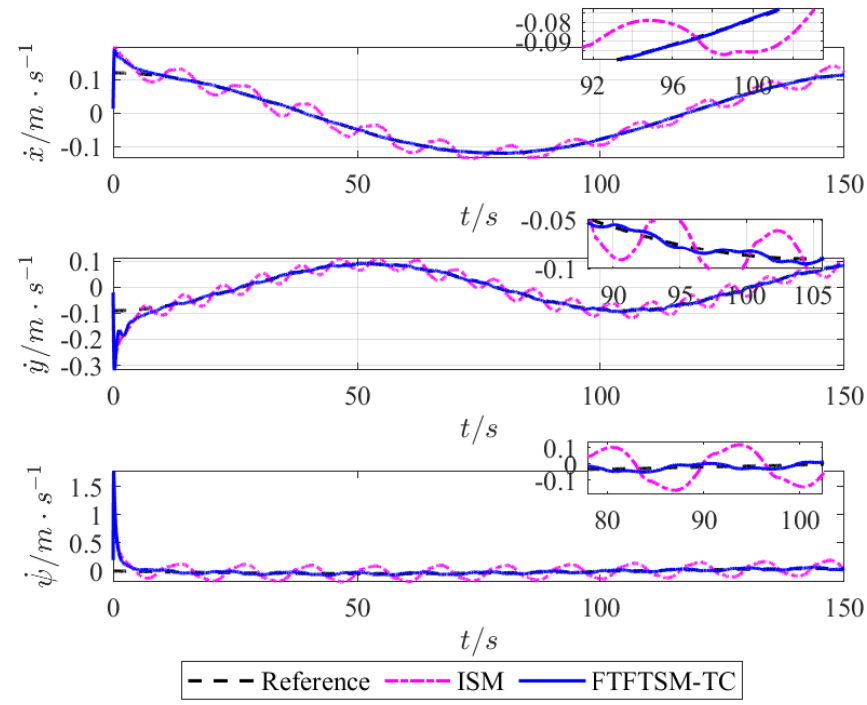
Figure 5. Velocity tracking of FTFTSM-TC and ISM-TC.